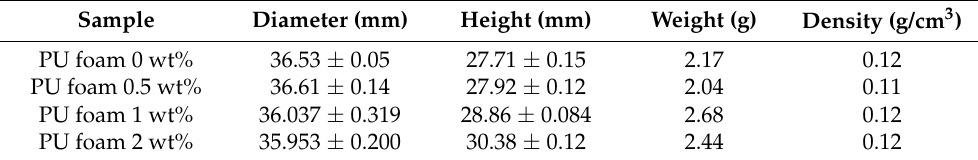
Table 2. Measures of manufactured PU foams with and without microcapsules.